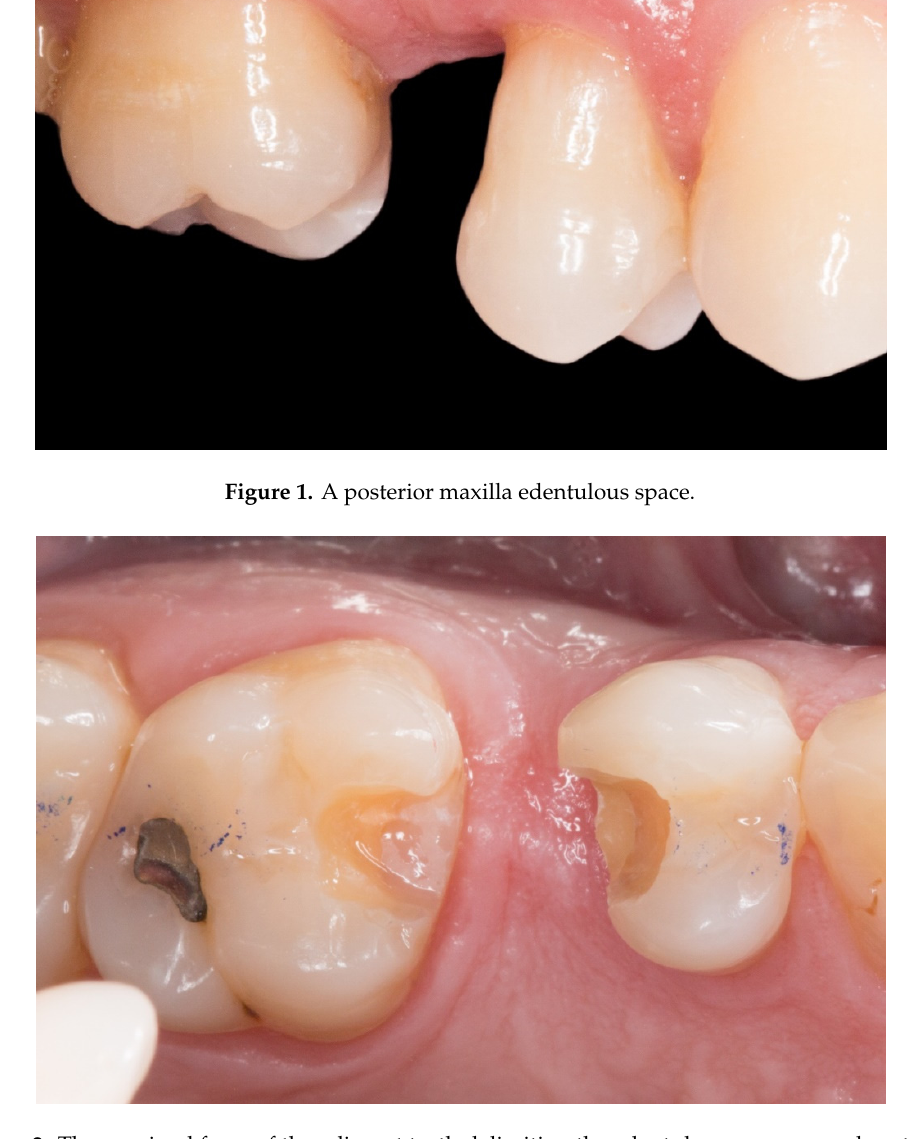
Figure 2. The proximal faces of the adjacent teeth delimiting the edentulous space carved up to the level of the ideal point of contact (inlay